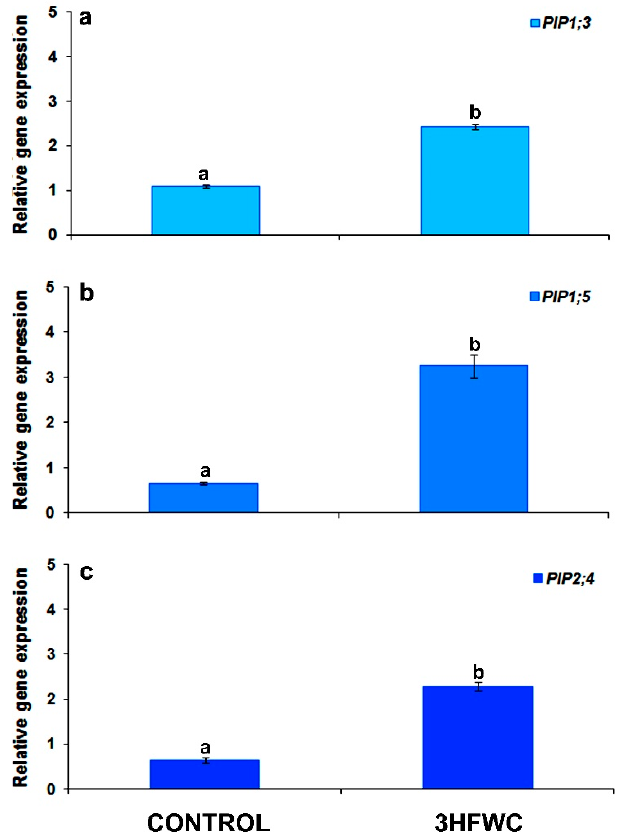
Figure 10. The effect of 3HFWC nanosubstance on relative expression of aquaporin genes in cherry tomato leaves after long-term exposure: ( a – c ) relative gene expression of PIP1;3 ( a ); PIP1;5 ( b ); and PIP2;4 ( c ).The gene expression was analyzed by the qRT-PCR method and normalized to the expression to 18s RNA. Data represent mean values ± standard error of three technical replicates. Different letters indicate statistically significant differences according to Duncan’s test (p ≤ 0.05).